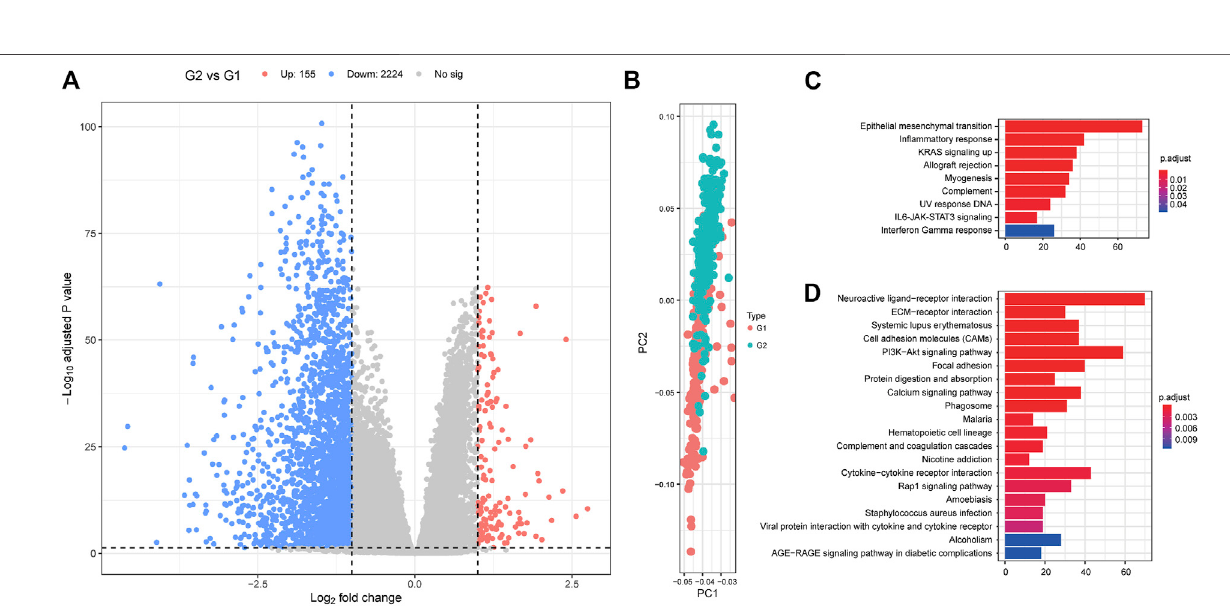
Frontiers in Genetics |